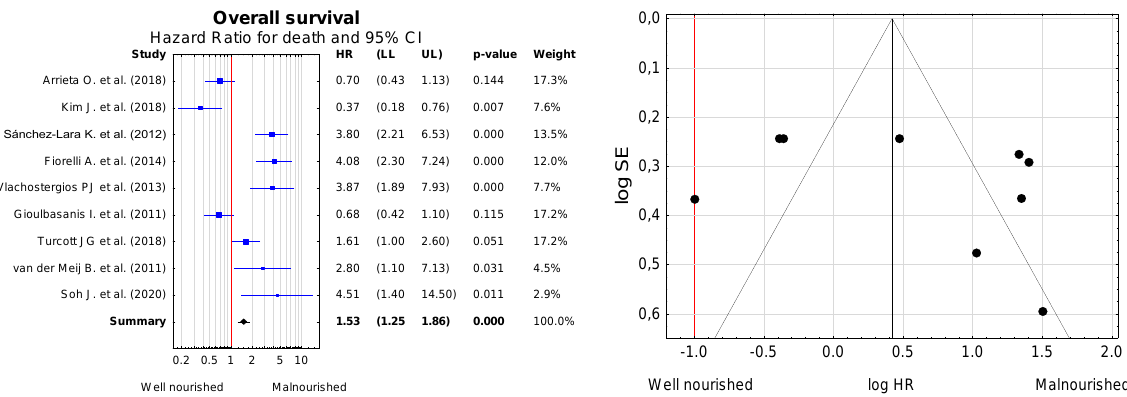
Figure 6. Risk of death in lung cancer patients differing by nutritional status (expressed by hazard ratio (HR)), and funnel plot for visual assessment of the probability of systematic bias due to selective publication of studies. LL — lower limit of the confidence interval; UL — upper limit of the confidence interval for the effect measure ( HR ).